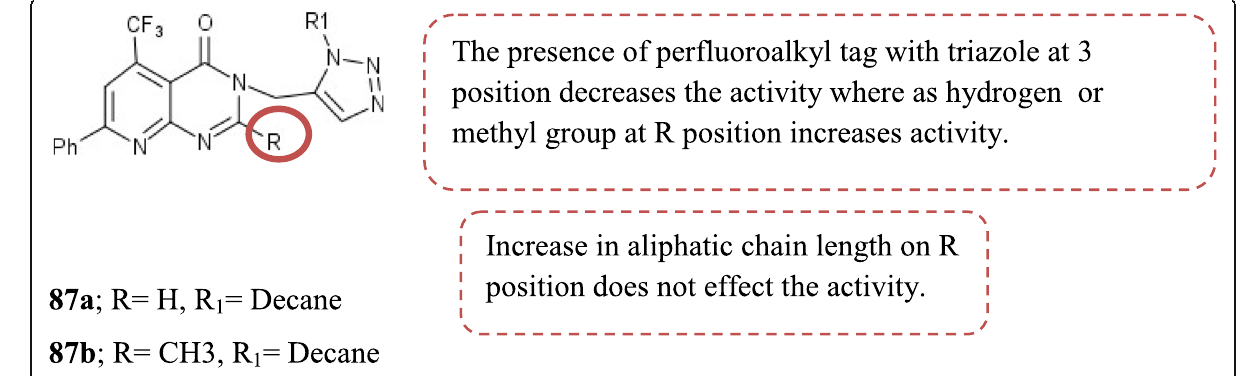
Fig. 29 SAR studies and chemical structures of pyrido pyrimidine derivatives